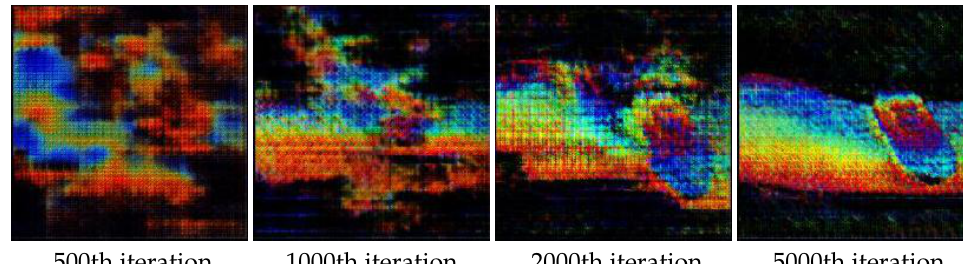
Figure 13. Output image of LN-PGAN.